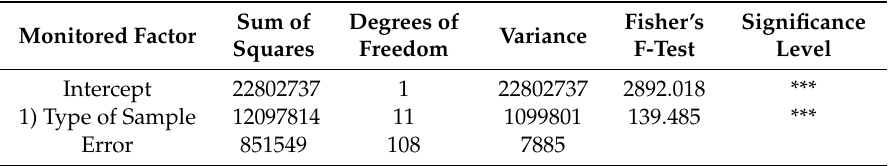
Table 13. Statistical evaluation of the e ff ect of the factors and their interaction on the minimum bend radius at the yield point ( R minC ) for beech and NWC on the bottom.